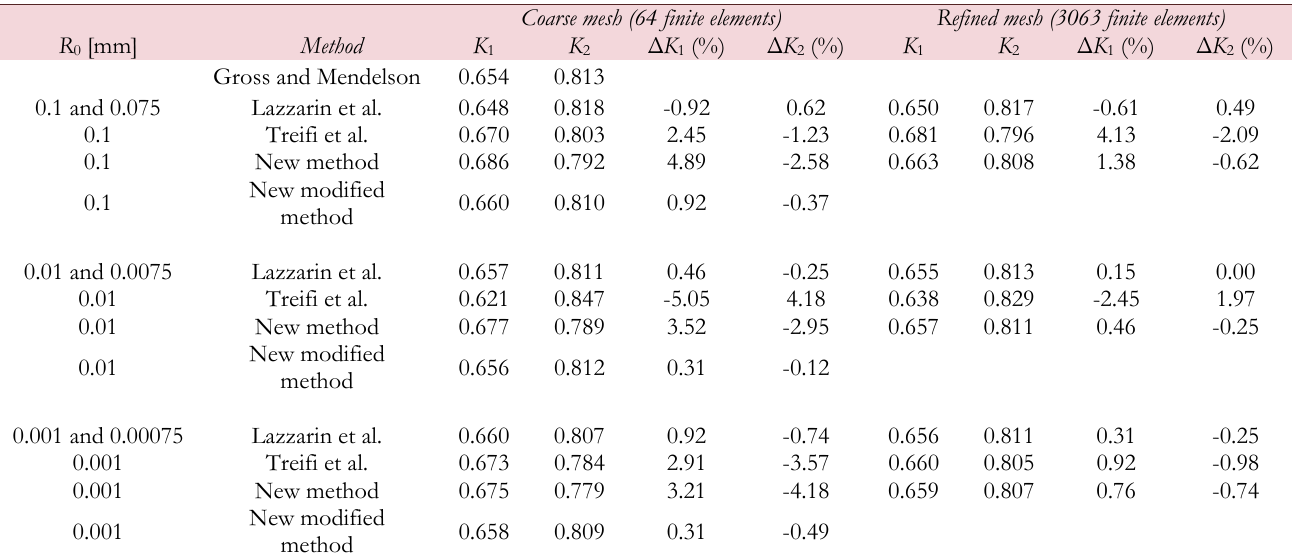
Table 2: Comparison between approximate methods for NSIFs evaluation of diamond-shaped notch (2 α =